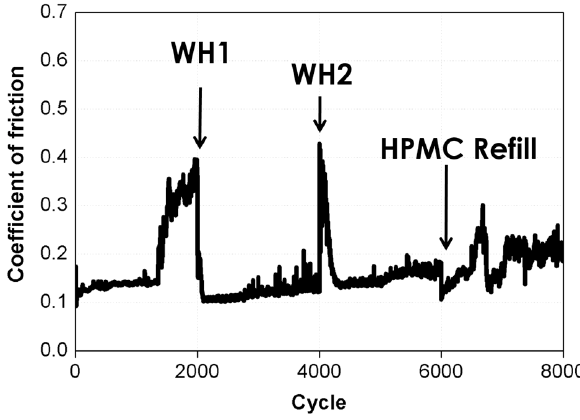
Figure 7. Coefficient of friction after the film was subjected to water healing twice and the HPMC solution was refilled once.